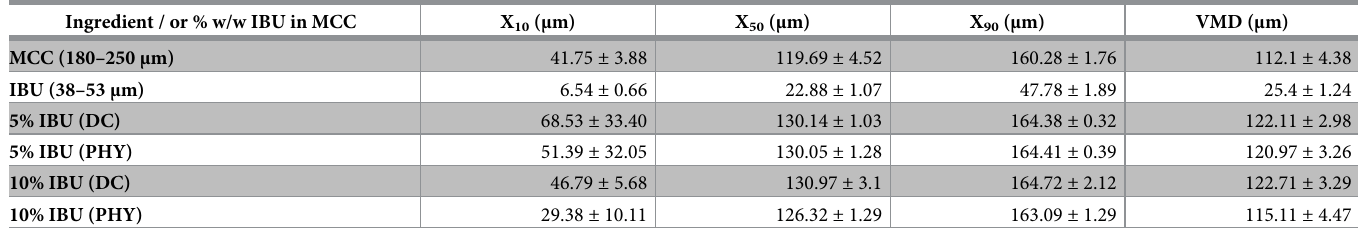
Table 3. Particle size distribution parameters for ibuprofen (IBU), MCC and the various mixtures (Dry coated (DC) and Physical (PHY)) using laser diffraction technique, (mean ± SD, n = 3). Ingredient / or % w/w IBU in